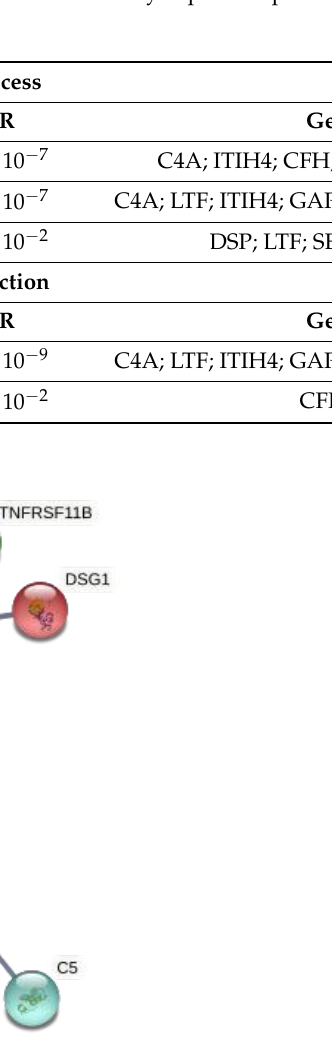
Figure 5. Protein–protein interaction network of the differentially expressed proteins after 6-month therapy with denosumab. The edges show protein–protein interactions with predicted functional partners. Edges have different colors according to their clustering with k means with input number 5. All lines represent known protein–protein interactions with high confidence.